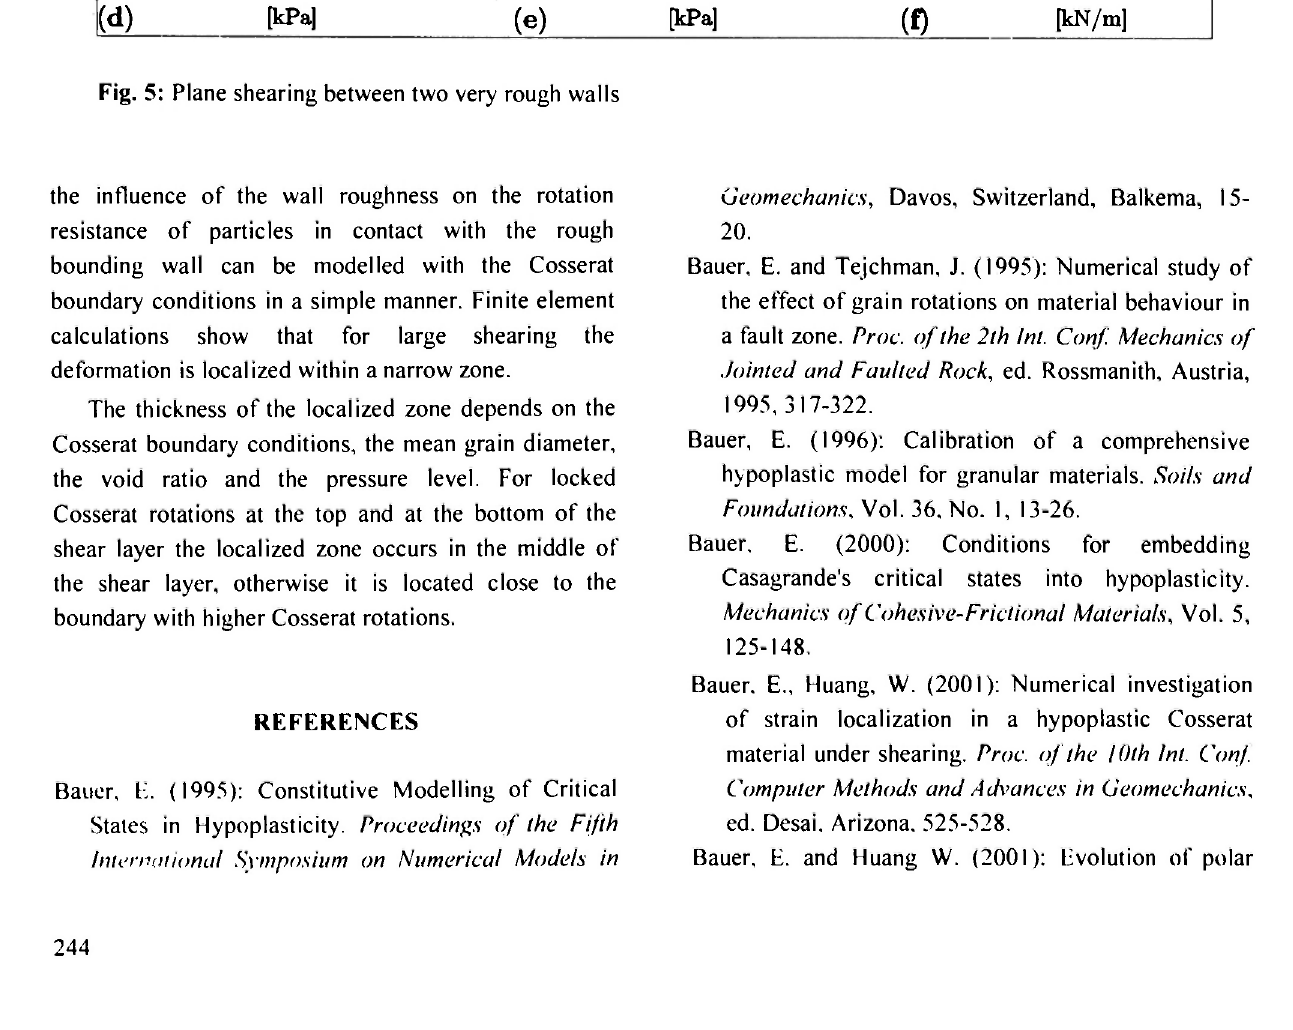
Fig. 5: Plane shearing between two very rough walls